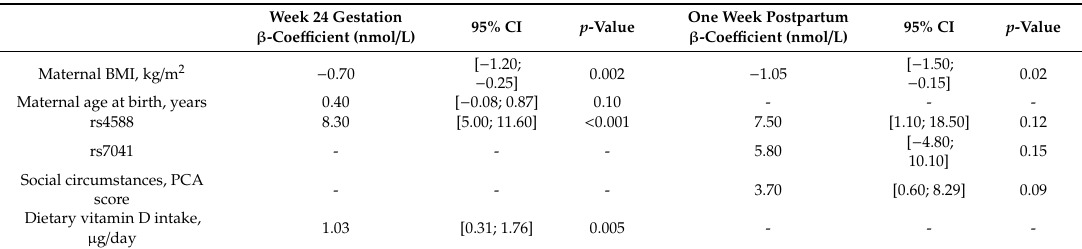
Table 2. Results from final multivariate forward regression analyses of maternal